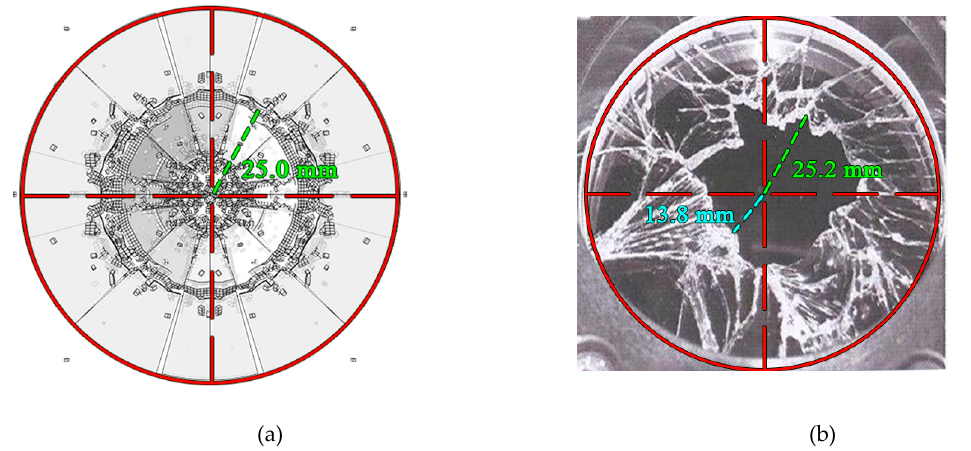
Figure 8. Comparison of the size of fragments. ( a ) Numerical result; ( b ) experimental result [46].